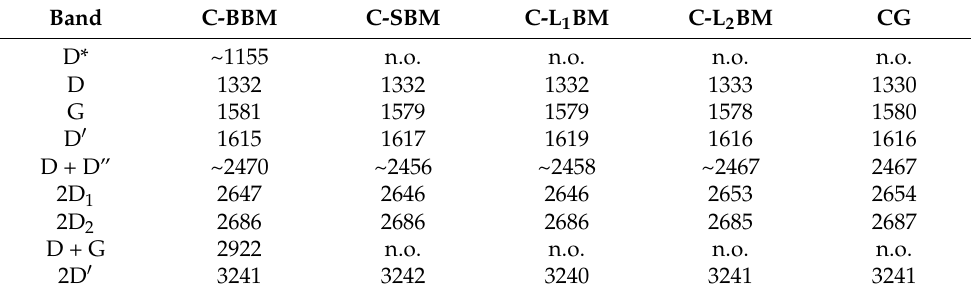
Table 5. Raman bands positions (cm − 1 ) observed in the investigated samples and their